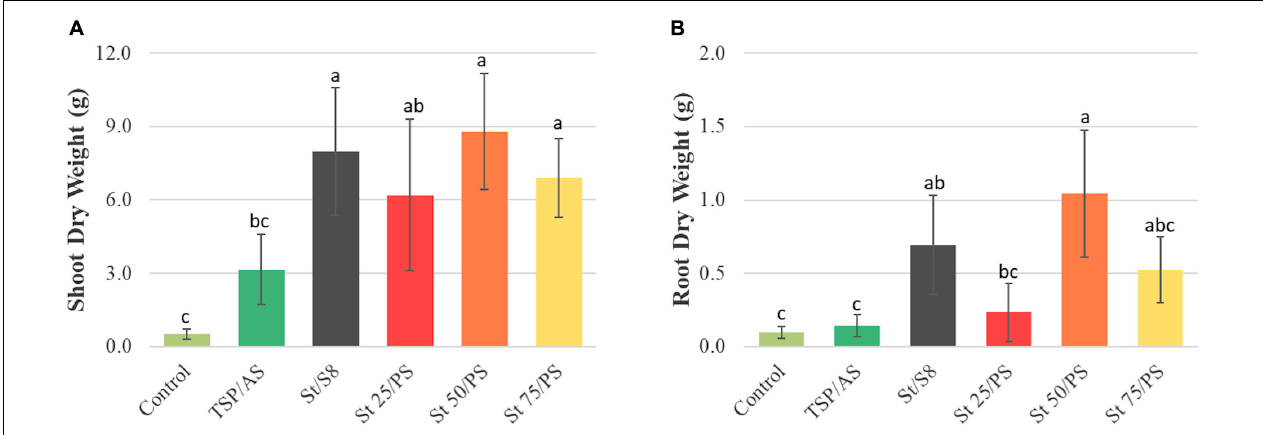
FIGURE 7 | Effect of treatments on biomass from (A) shoots and (B) roots. Bars show mean values ± standard deviations. Indexes a, b, and c indicate significant differences between treatments ( p < 0.05).